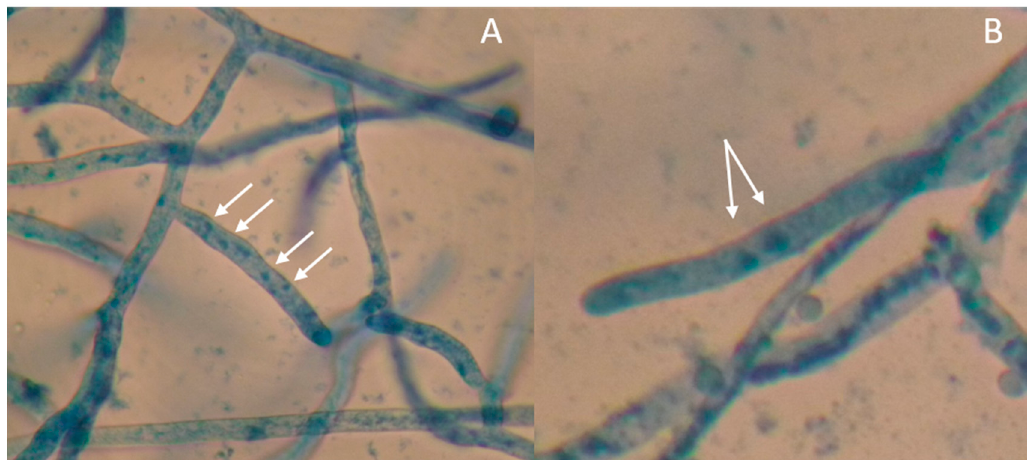
Figure 5. Photomicrograph of 24-h-old hyphal tips stained with 0.5% aniline blue showing multinucleate Rhizoctonia isolate LScL (A) and binucleate Rhizoctonia isolate BIG (B) as indicated by the arrows. Samples were viewed at 40×.